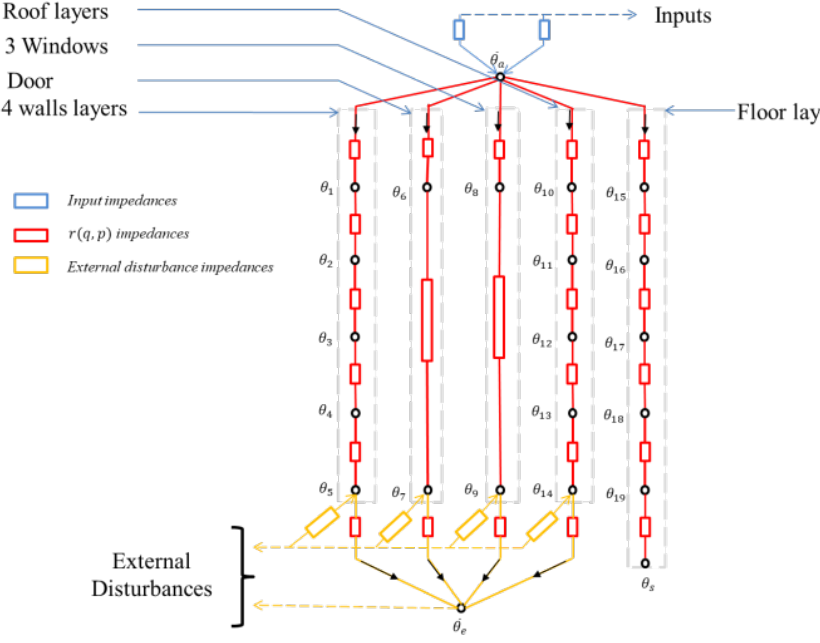
Figure 4. The thermal SCN scheme of the mono-zone eco-cottage.